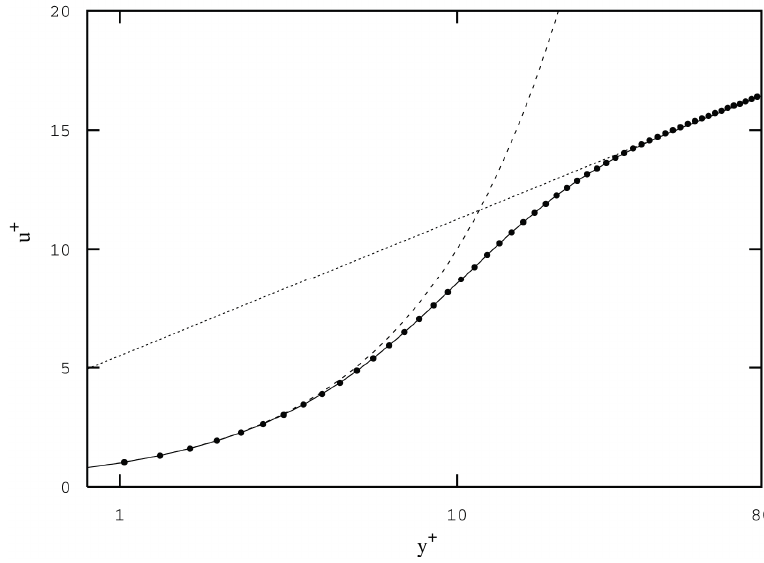
Figure 4. Computational test-case. Mean streamwise-velocity profile: (—) reference solver, ( ●● ) Flow-3D solver, (---) law of the wall u Table 3. Characteristic parameters used for the test-case simulations ( Re 200